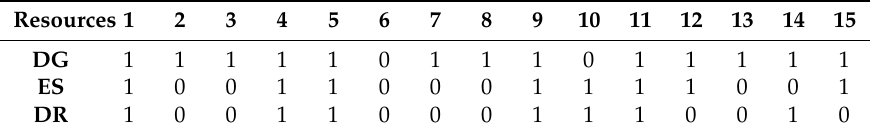
Table 1. Distribution of resources in each area.